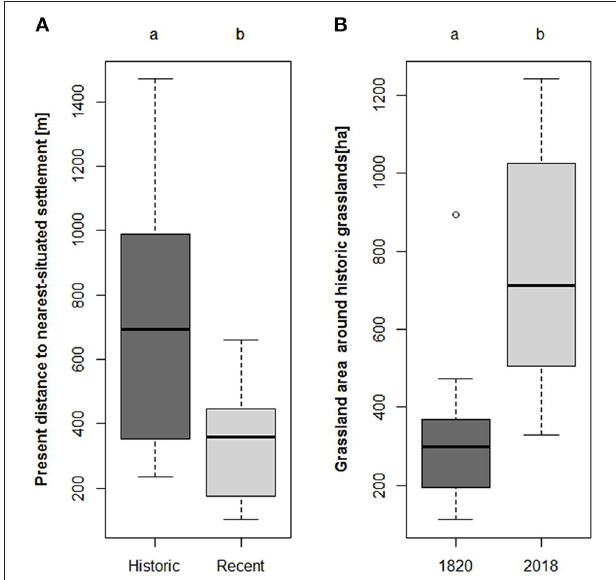
FIGURE 3 | (A) Present distance to the nearest-located settlement or city separated for the two age categories of the investigated grasslands. A Dunne test revealed ancient grasslands to be located further away from settlements than recent grasslands ( p = 0.028). (B) Grassland area [ha] around ancient grasslands in 1,820 and at present. The amount of grassland around ancient grasslands increased significantly ( p <